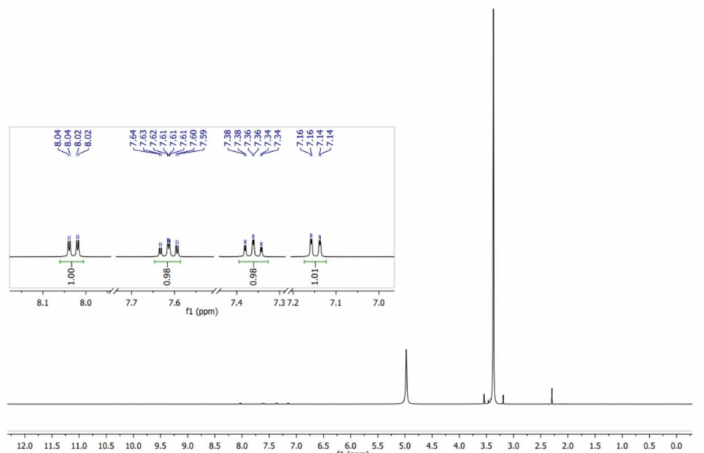
Figure 2. 1 H NMR spectrum (in MeOH) of the purified ASA utilized for the study of the transesterification–esterification reaction catalyzed by SiO 2 –SO 3